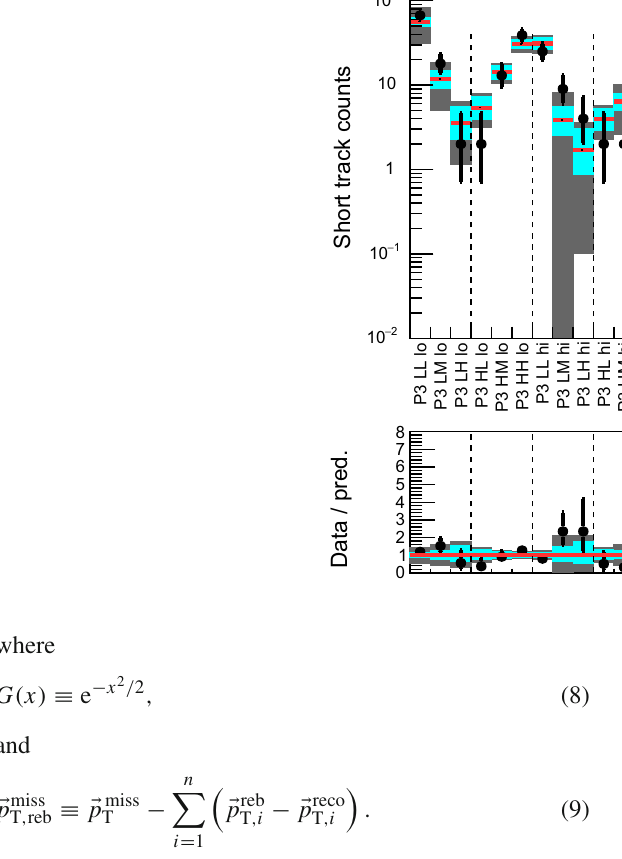
Data Prediction, statistical errors Prediction, with total